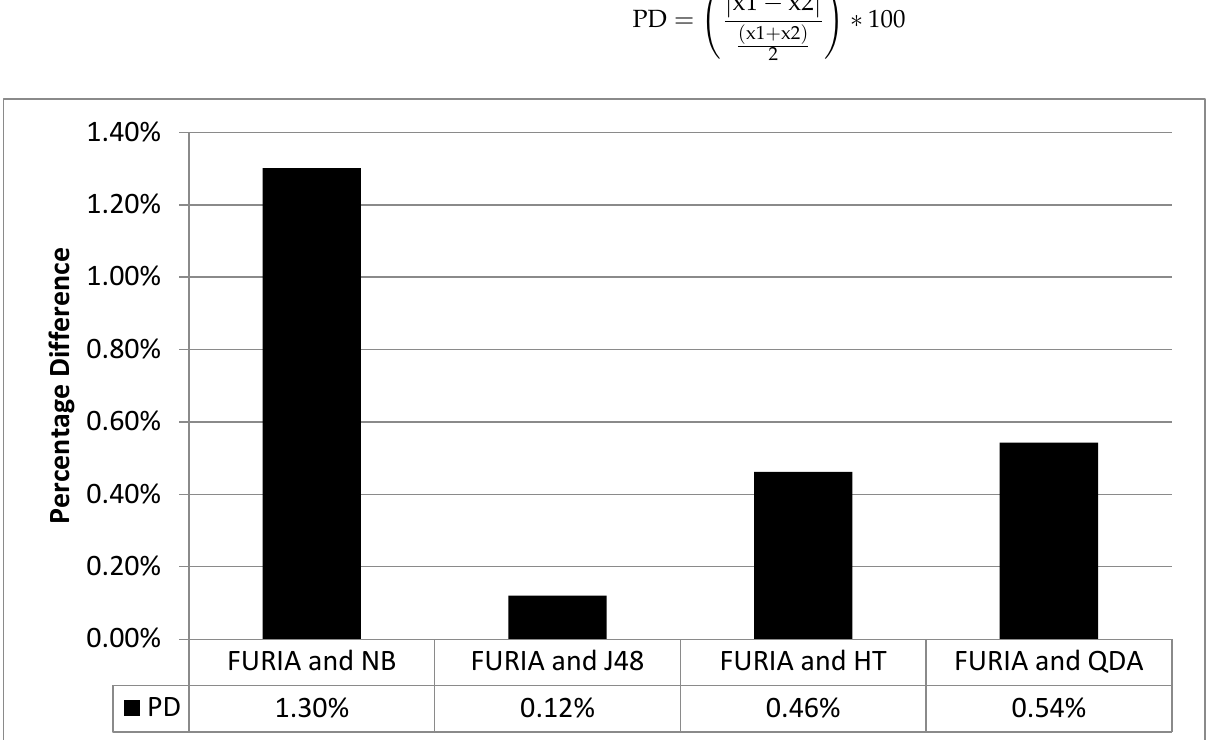
Figure 7. Accuracy percentage difference between FURIA and other employed models.